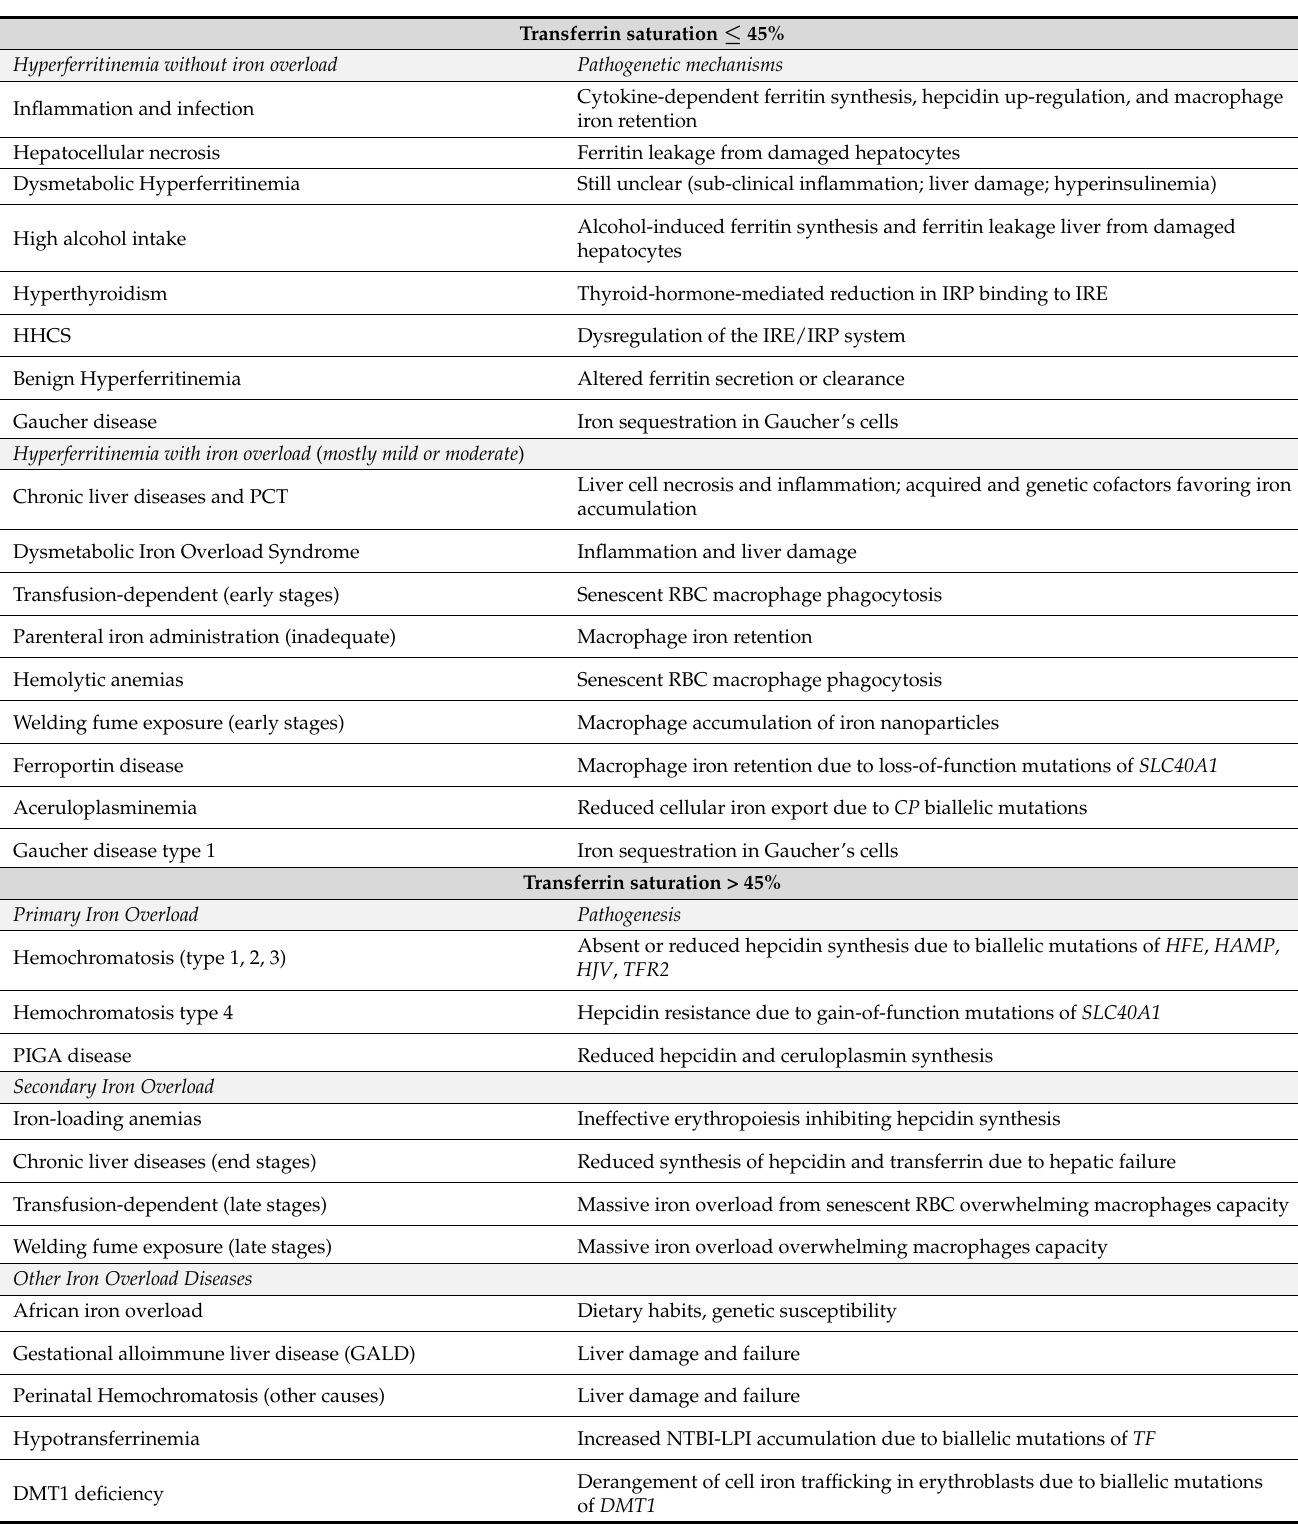
Table 1. Causes and pathogenetic mechanisms of hyperferritinemia divided according to transferrin